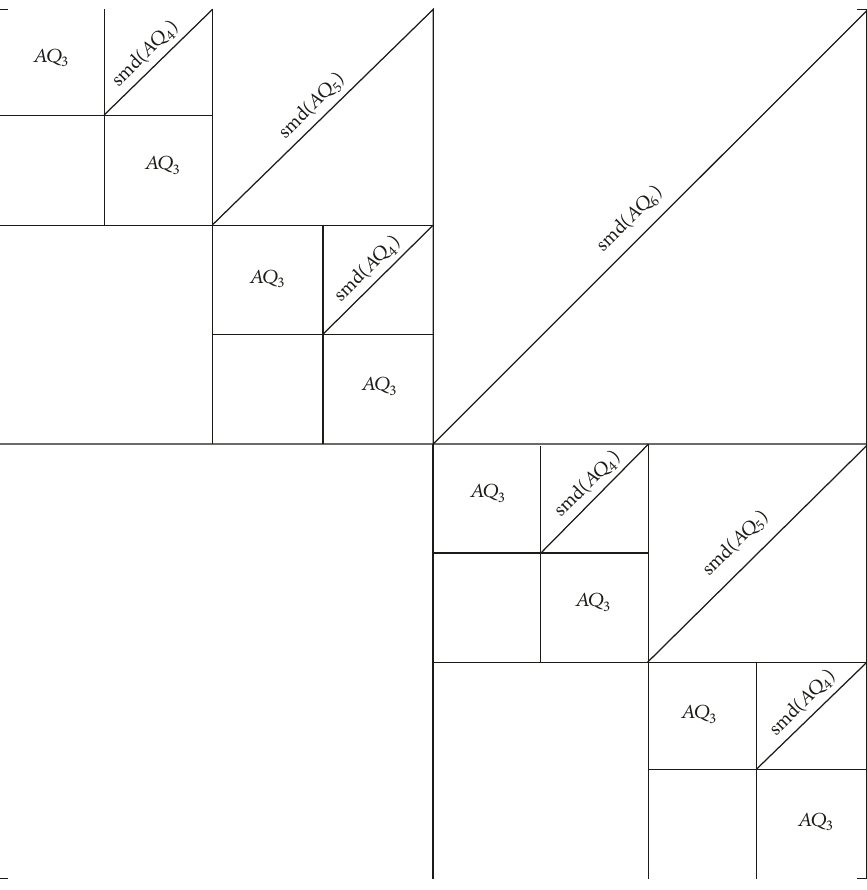
Figure 5: The adjacency matrix of size 2 6 × 2 6 of 𝑄 6